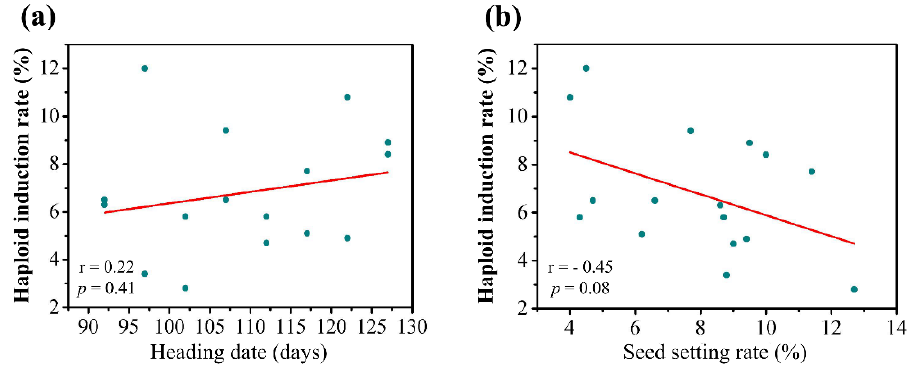
Figure 6. Correlation analysis between haploid induction rate (HIR) and heading date ( a ) and between HIR and seed-setting rate ( b ).